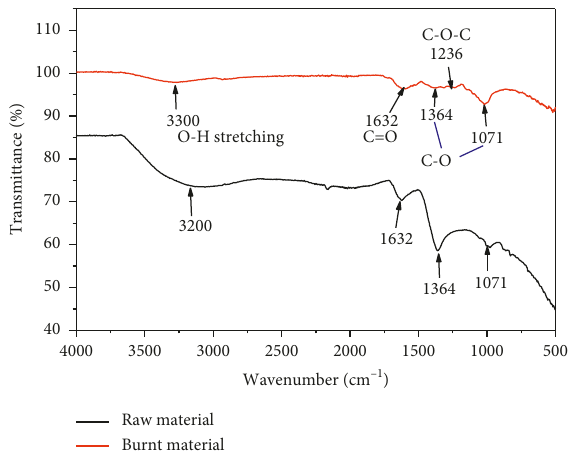
Figure 7: FTIR spectra of (a) RPG and (b) BPG.